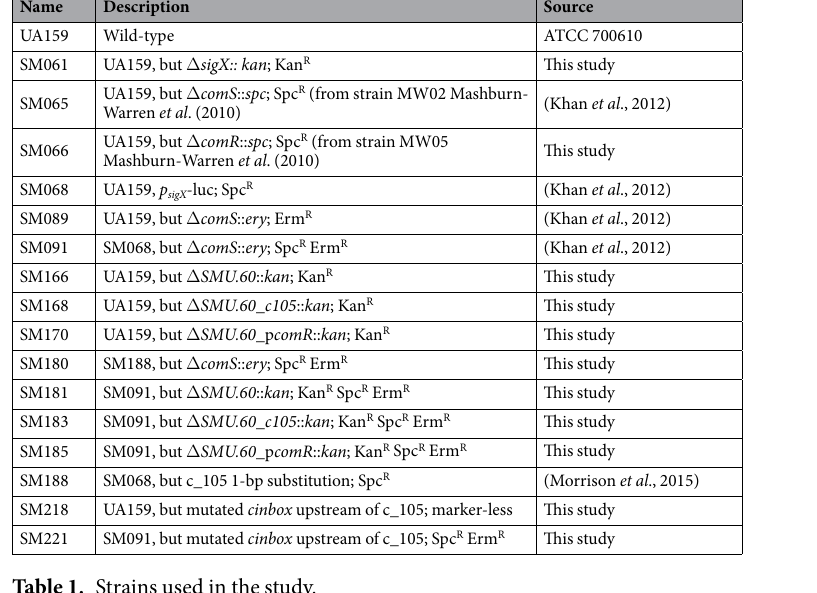
Table 1. Strains used in the